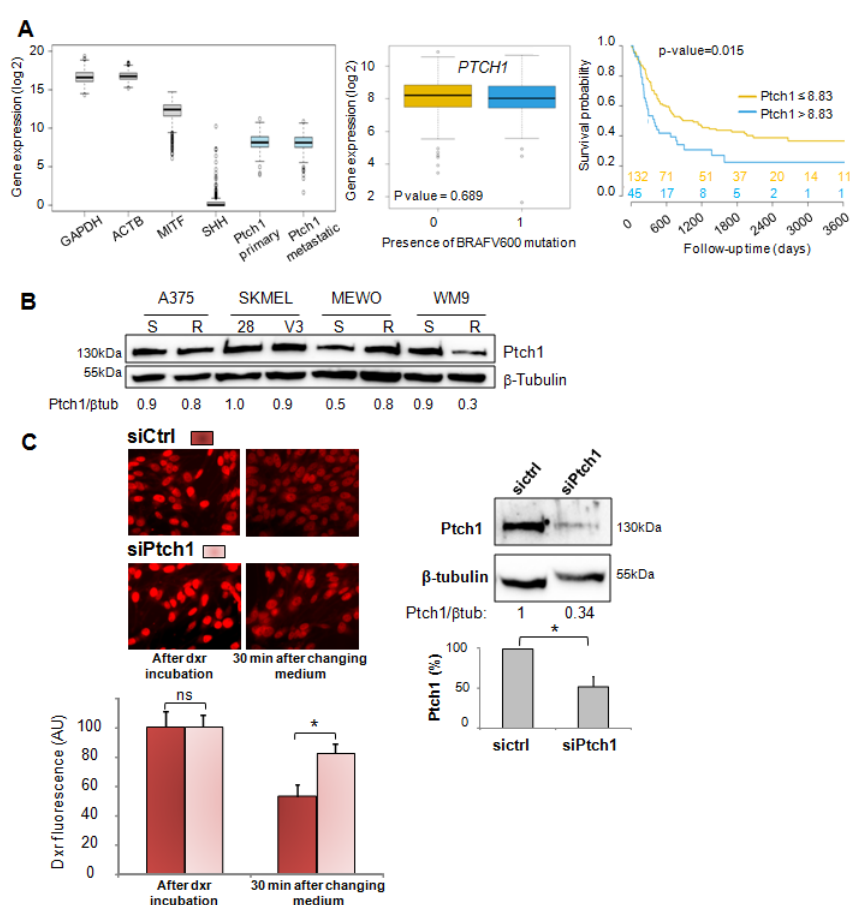
Figure 1. Ptch1 is expressed in patients-derived melanoma specimens and melanoma cell lines, and transports chemotherapy agents out of cells. ( A ). Ptch1 is expressed in patients-derived melanoma specimens and decreases survival in metastatic patients. Left panel: Distribution of gene expression level of PTCH1 , GAPDH , ACTB , MITF , and SHH . Middle panel: Distribution of PTCH1 gene expression by the presence or the absence of any BRAF V600 mutation for metastatic samples (0: no mutation ( n = 217), 1: presence of a mutation ( n = 151). Right panel: Kaplan–Meier analysis of overall survival for a subset of patients with metastatic disease and did not receive immunotherapy. Patients were grouped by their level of Ptch1 protein expression (low: Ptch1 expression ≤ 8.83, high: Ptch1 expression > 8.83). The number of patients in each group over time is displayed at the bottom of the graph. ( B ). Ptch1 is expressed in melanoma BRAF V600 mutant cell lines. Western blots were performed on extracts from various melanoma cell lines with antibodies directed against Ptch1. ( C ). Ptch1 contributes to the efflux of doxorubicin from melanoma cells. Ptch1 protein expression (right panel) and intracellular doxorubicin (dxr; left panel) were analyzed after transfection of MeWo cells with Ptch1-siRNA or negative-control-siRNA. After incubation with dxr, 3 coverslips were fixed for dxr loading control; the other coverslips were incubated with efflux buffer and fixed. Dxr fluorescence images were acquired using a 40× objective, and dxr fluorescence was quantified using ImageJ software for about 100 cells per condition per experiment. Ptch1 and β -tubulin signals on Western blots were quantified using ImageJ software. All data presented are the mean ± SEM of 3 independent experiments. Significance is attained at p < 0.05 (*), ns: no significant di ff erence. The uncropped blots and molecular weight markers of Figure 1B,C are shown in Figure